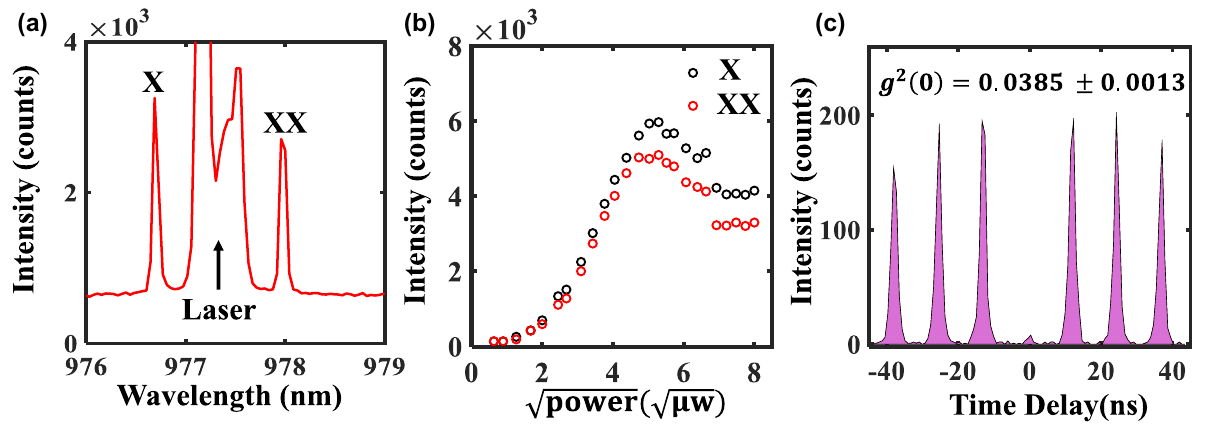
Figure 6: Two photon excitation of a 980 nm SQD on DBR. (a)Photoluminescencespectraofthebiexciton – excitoncascadeandasuppressedexcitationlaser.(b)Emissionintensityoftheexciton(black circles)andbiexciton(redcircles)linesunderTPEasafunctionofthesquarerootofthepumppower,illustratingthedampedRabioscillations. (c) Second-order autocorrelation measurement of g (2) ( t ) for typical QD exciton in